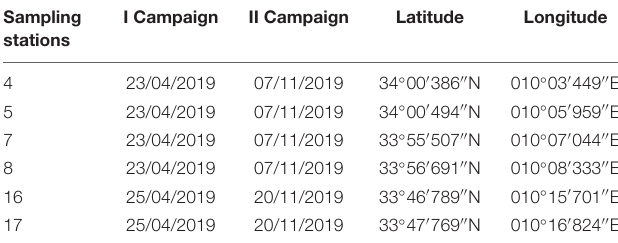
TABLE 1 | Gulf of Gabes sampling